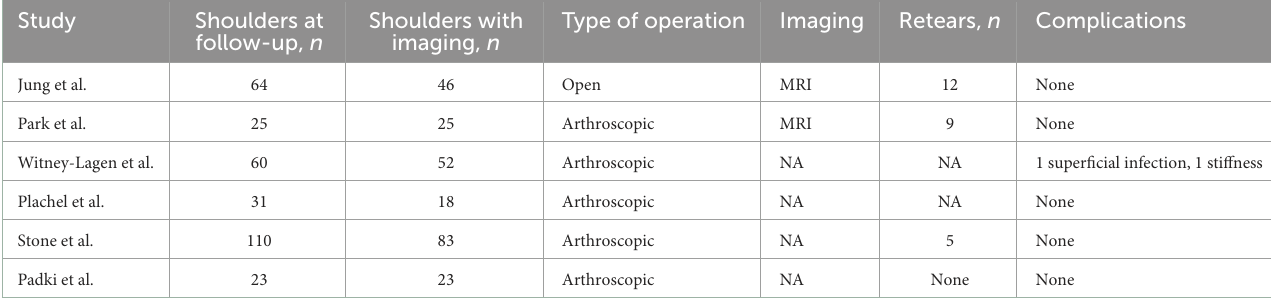
TABLE 4 Rotator cuff integrity and complications. Study Shoulders at Shoulders with Type of operation Imaging Retears, n Complications follow-up, n imaging, n Jung et al. 64 46 Open MRI 12 None Park et al. 25 25 Arthroscopic MRI 9 None Witney-Lagen et al. 60 52 Arthroscopic NA NA 1 superficial infection, 1 stiffness Plachel et al. 31 18 Arthroscopic NA NA None Stone et al. 110 83 Arthroscopic NA 5 None Padki et al. 23 23 Arthroscopic NA None